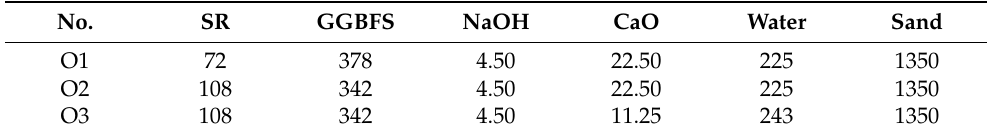
Table 4. Group II, optimal experiment of mortars